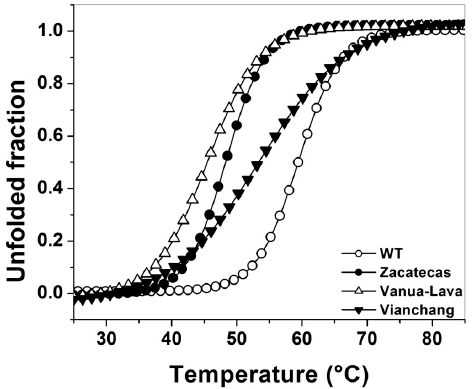
Figure 4. The mutations decrease the thermal stability of WT G6PD enzyme. The determination of melting temperature ( T m ) was monitored by recording the change in the CD signal at 222 nm when the temperature was increased progressively from 20 to 90 °C at 1°/2.5 min. In all cases, both the WT G6PD and the mutants were recorded at 0.8 mg/mL in 25 mM phosphate buffer pH 7.35. Experiments were performed in duplicate; standard errors were less than 5%.